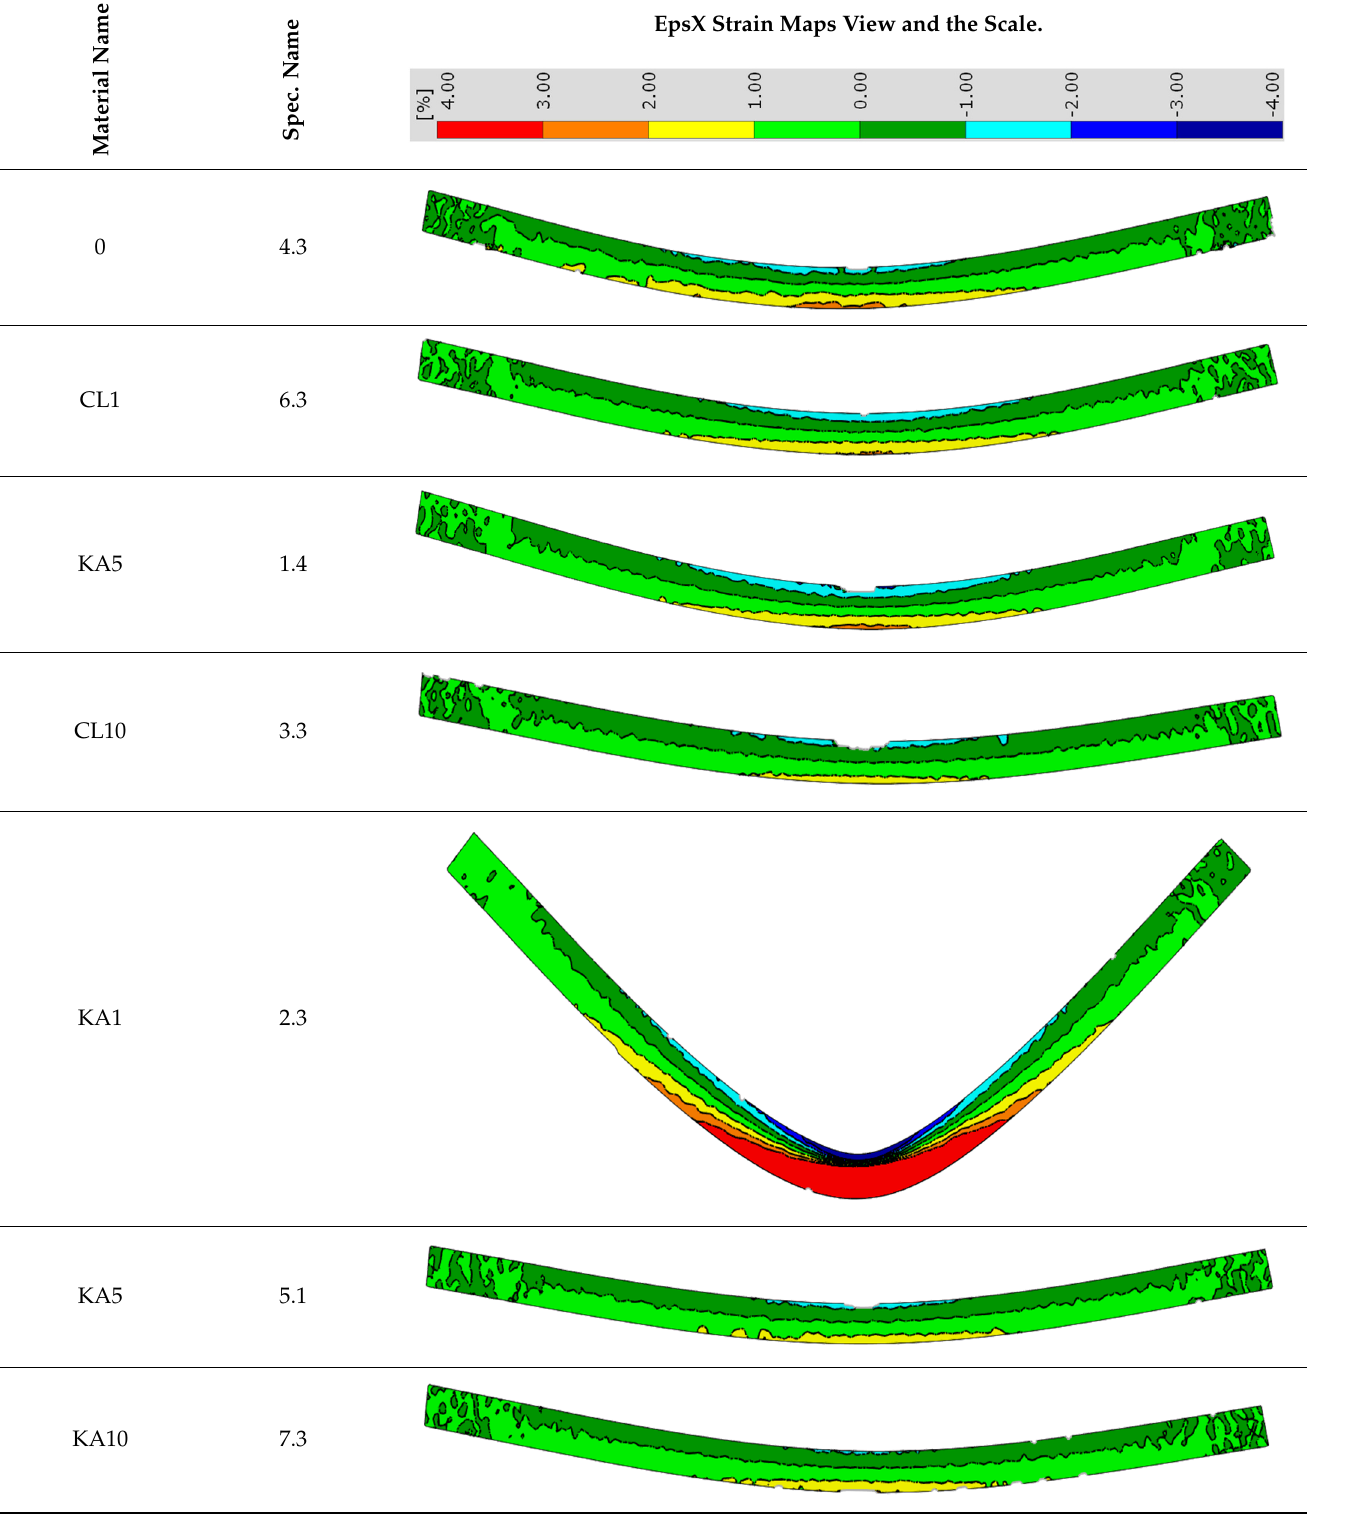
Table 5. EpsX deformation maps.